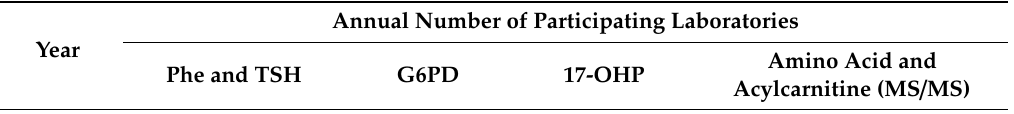
Table 1. Annual number of laboratories participating in external quality assessment (EQA)